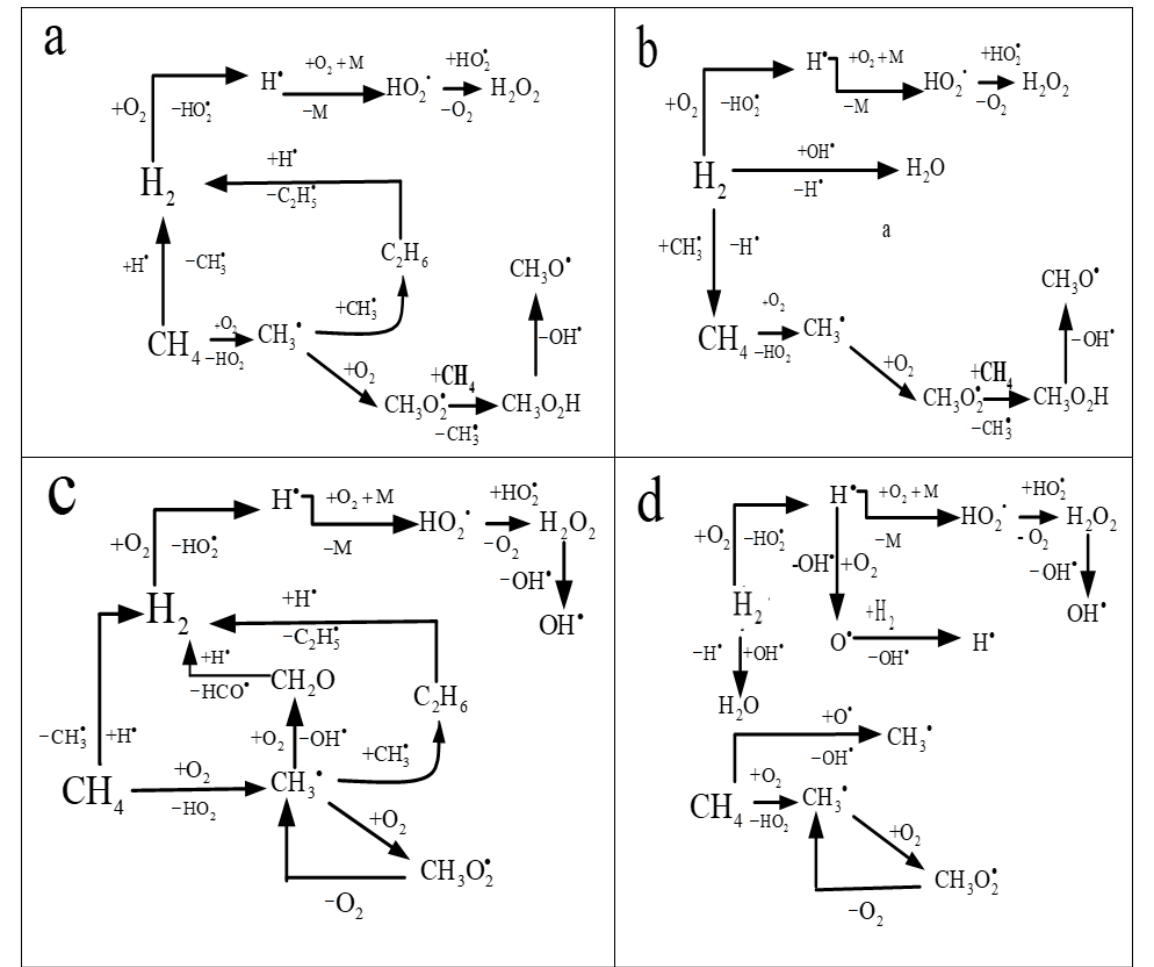
Figure 13. Main routes of conversion of reagents in the chain mechanism of ignition of mixtures CH 4 -H 2 -air. ( a ) — [H 2 ] = 20%, T 0 < 900 K; ( b ) [H 2 ] = 80%, T 0 < 900 K; ( c ) — [H 2 ] = 20%, T 0 > 900 K; ( d ) — [H 2 ] = 80%, T 0 > 900 K.